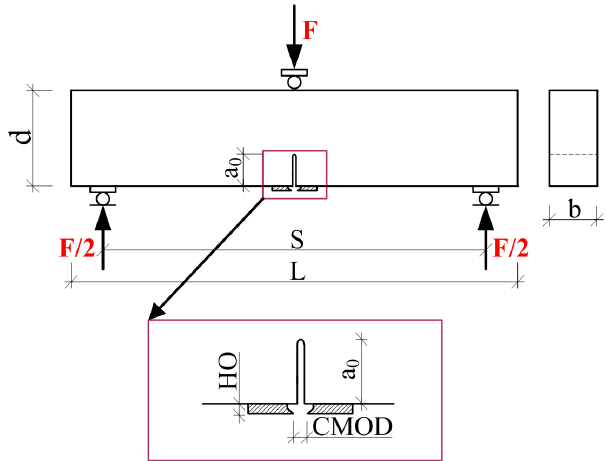
Figure 4. Schematic drawings of the specimen used in the fracture toughness examination according to mode I: HO—clamp gauge holder thickness, CMOD—crack mouth opening displacement. mode I: HO—clamp gauge holder thickness, CMOD—crack mouth opening